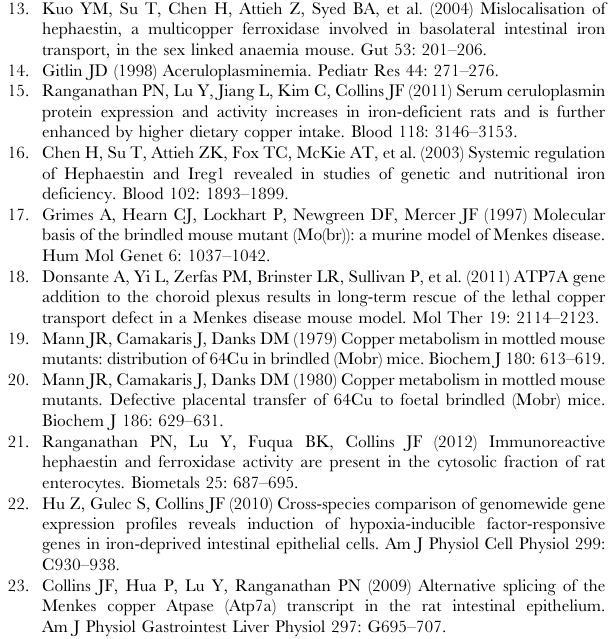
Figure S1 Relative Cp activity as a function of serum and liver copper levels. Plots show the relationship between serum (A) and liver (B) copper and Cp activity. Lines fitting the data were derived by linear regression for Cp activity versus serum and liver copper. In panels A and B, P , 0.0001. r, Pearson correlation coefficient. Table S1 Sequences of Oligonucleotide Primers Used for qRT-PCR Analysis. Forward (F) and reverse (R) primers used for PCR analysis of gene expression are listed. Cyclophilin was utilized as an internal standard for normalization of experimental gene expression. Table S2 Summary of Iron- and Copper-Related Pa- rameters in Experimental Mice. A summary of all data obtained in this investigation is listed. Parameters that were not different between groups are shaded blue. Yellow shading indicates an increase in this parameter as compared to WT mice. Fold increases were estimated by averaging the values from increased groups that were not statistically different from one another. Green shading indicates parameters that were decreased as compared to WT mice. Percent of the WT values are shown. Percent of WT values were estimated by averaging the values from decreased groups that were not statistically different from one